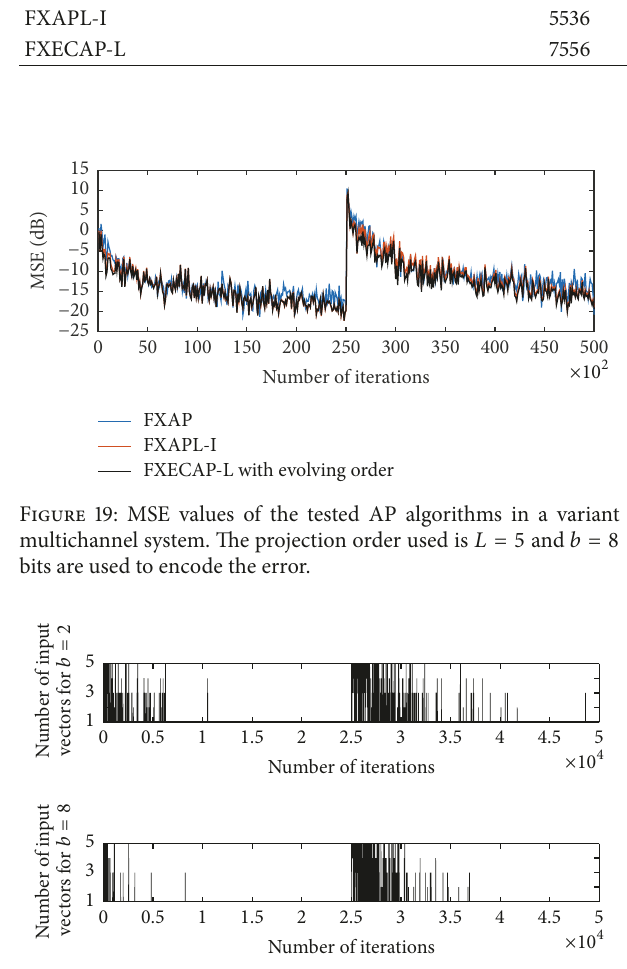
Figure 20: Numbers of input vectors used in the proposed FXECAP-L algorithm when 𝐿 = 5 and 𝑏 = 2 or 𝑏 = 8